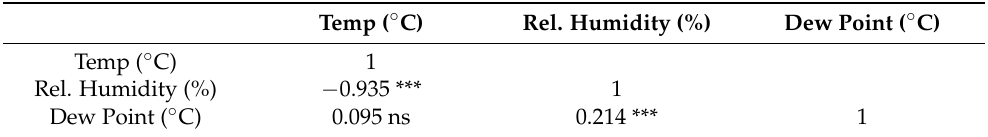
Table 4. Pearson’s correlation coefficients for temperature, relative humidity and dew for N = 391 data